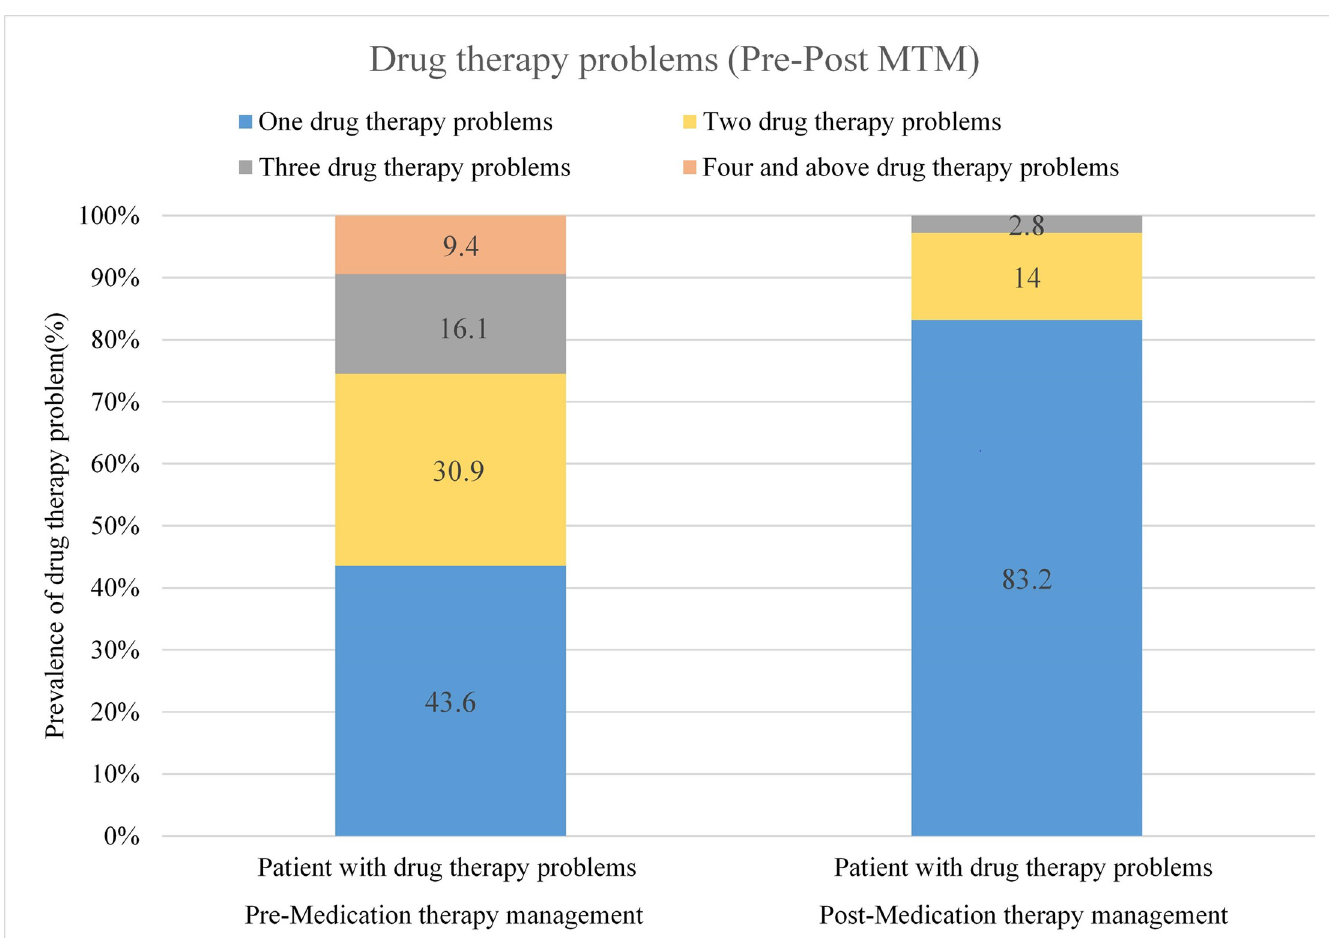
Fig 1. Drug therapy problems among adult patients with